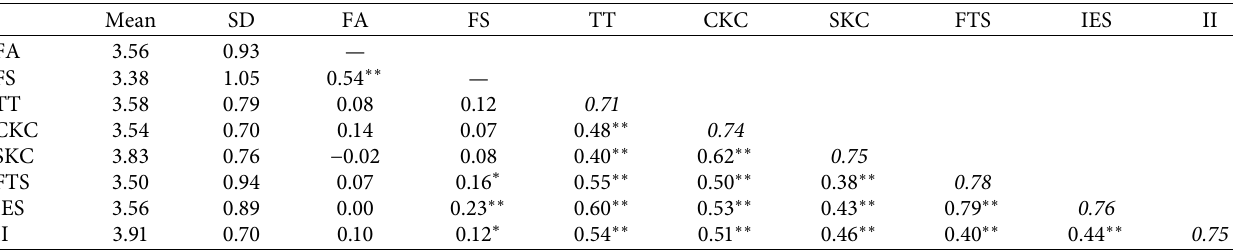
Table 2: Descriptive statistics and correlation